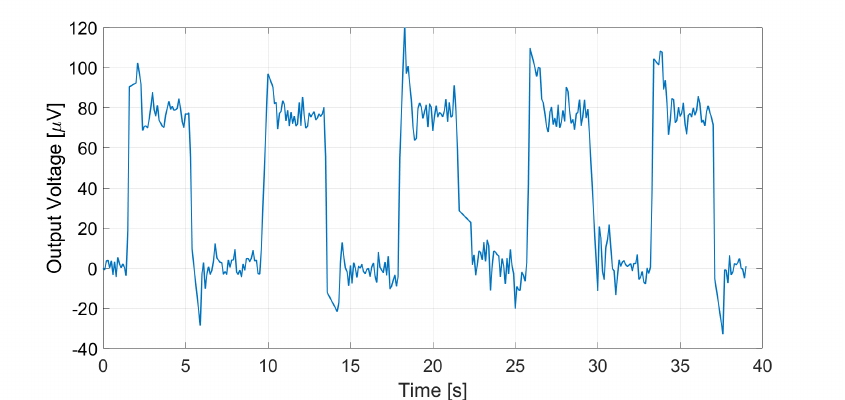
Figure 18. Measured E2 thermopile output in the case of a hand moved in front of the sensor at 5 cm